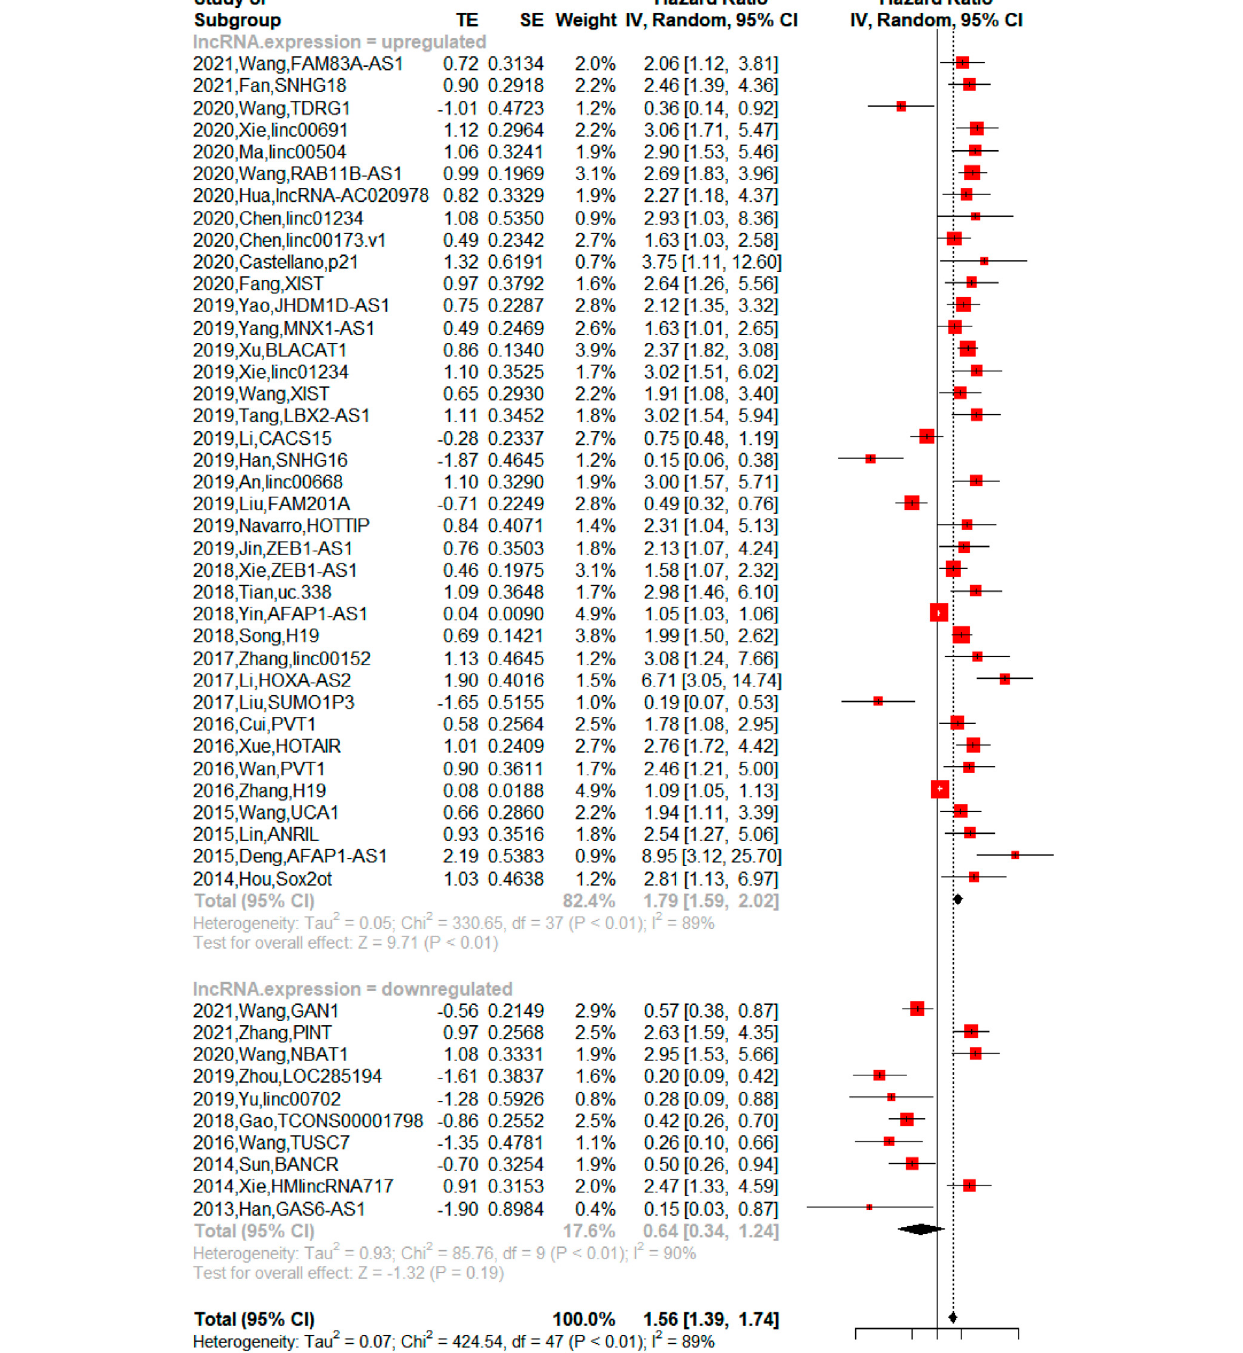
Frontiers in Genetics |